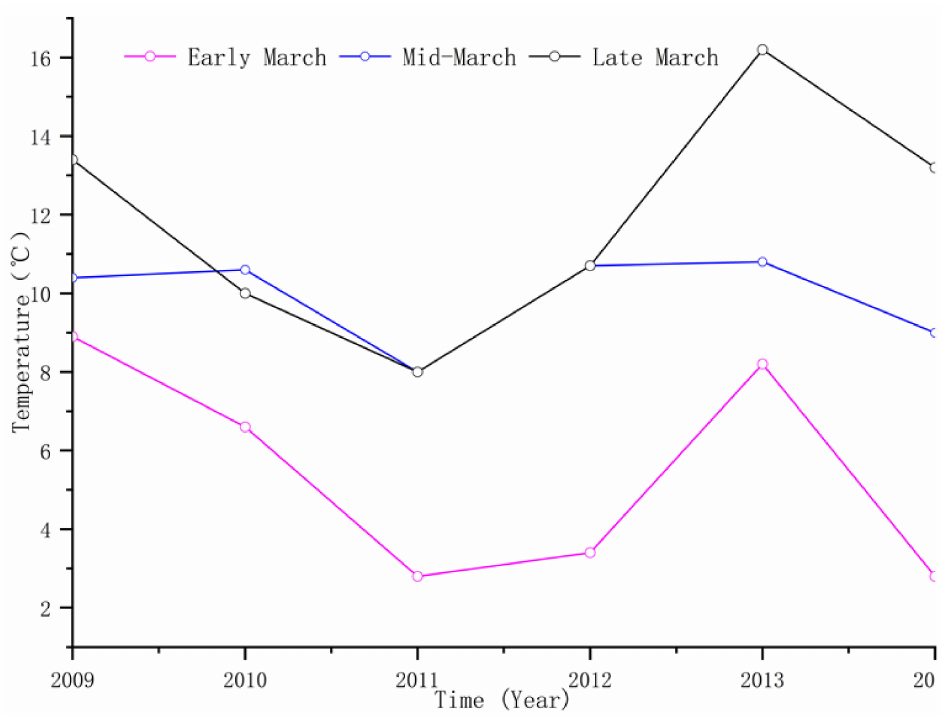
Figure 8. Average temperature in March from 2009 to